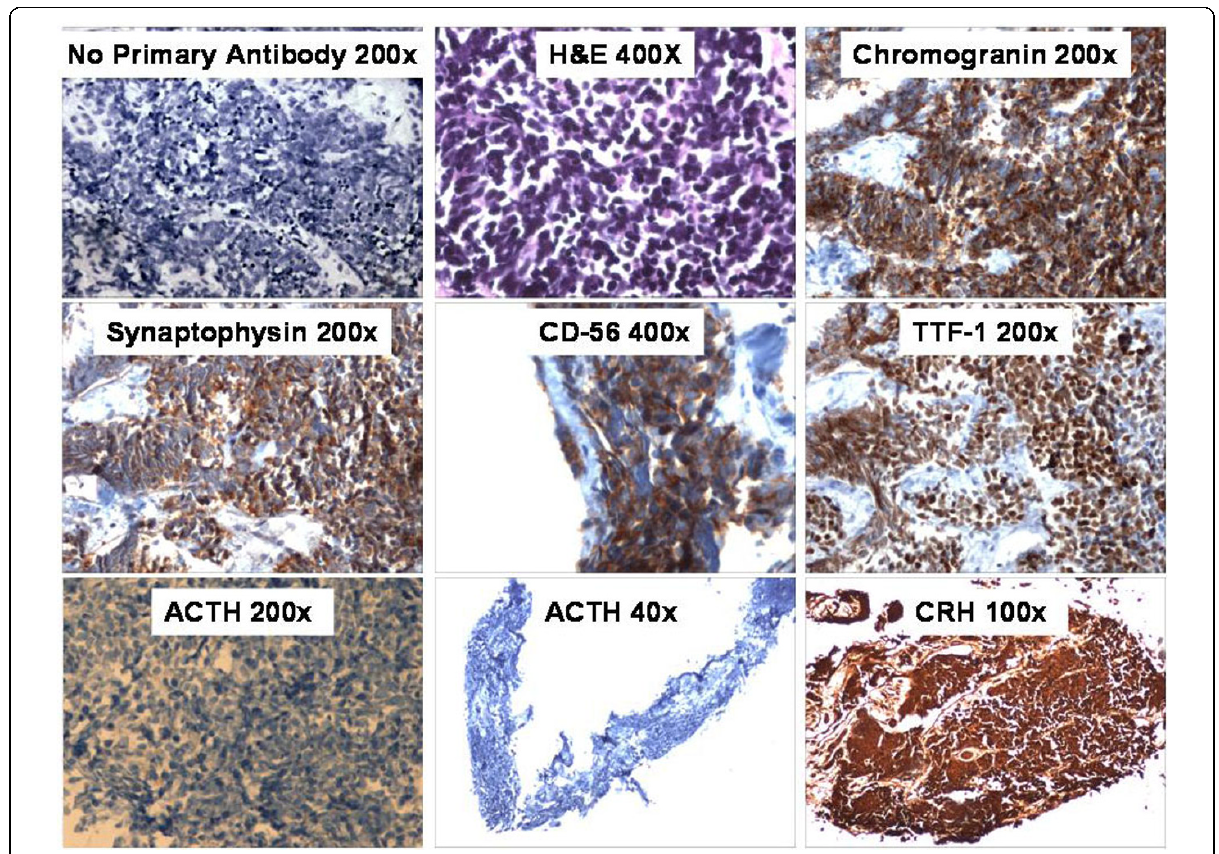
Figure 2 Immunohistochemistry of biopsy samples from a CT guided biopsy of a liver metastasis. The cells stained positively for chromogranin, synaptophysin, thyroid transcription factor 1 (TTF-1) and CD-56. The cells stained negatively for ACTH but were strongly positive for CRH.